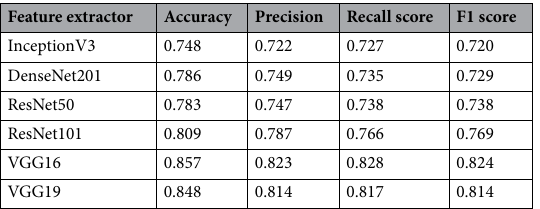
Table 5. Comparison of Performance among feature extractors with CNN classifier.